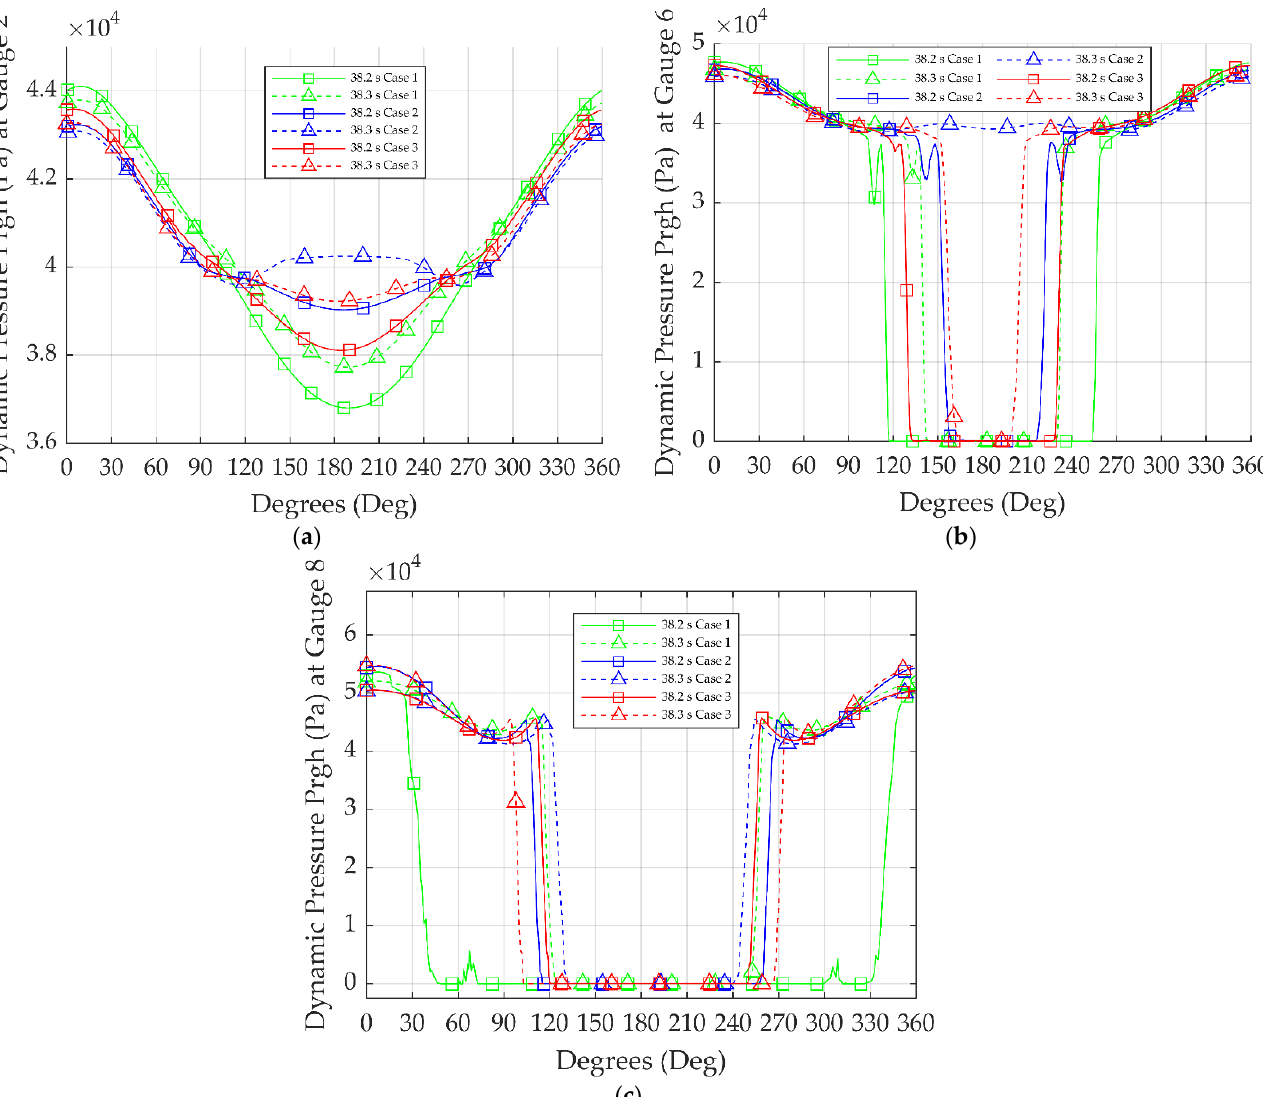
Figure 13. Comparison of the pressure distribution around substructures at different heights, for: ( a ) Gauge 2, ( b ) Gauge 6, and ( c ) Gauge 8. Table 12. Comparison of the pressure distribution around substructures at different heights.